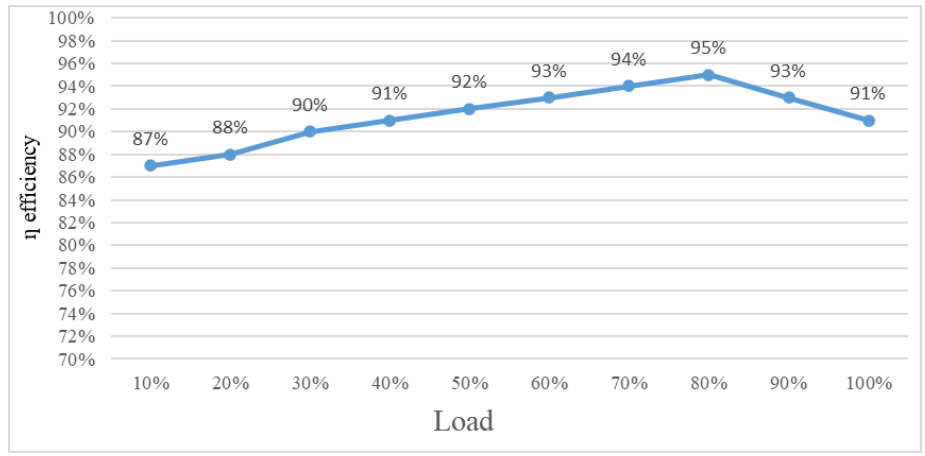
Figure 19. Conversion efficiency curve of the proposed hybrid converter operated in the solar power condition from light loads to heavy loads.